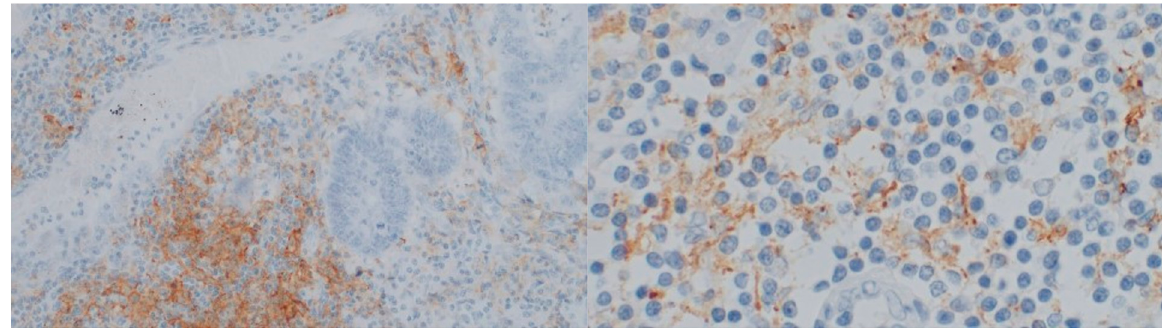
Figure 4. Immunostaining for RANTES (Opta Tech 2200 Camera, magnification 10× and 60×). Cyto ‐ plasmatic positive IHC staining for RANTES in tumor ‐ infiltrating lymphocytes.